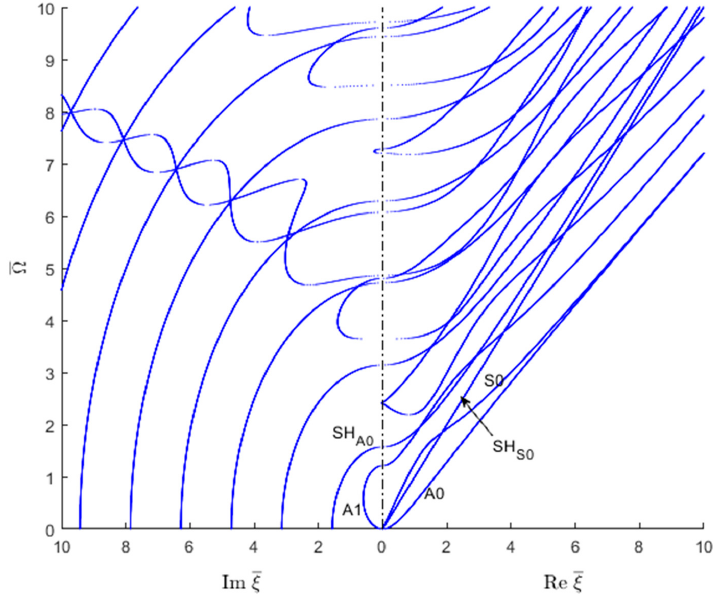
Figure 21. Complex wavenumber trajectories for 90-degree wave propagation in a 1-mm laminated unidirectional CFRP composite plate (wave propagation direction is perpendicular to the fiber direction).